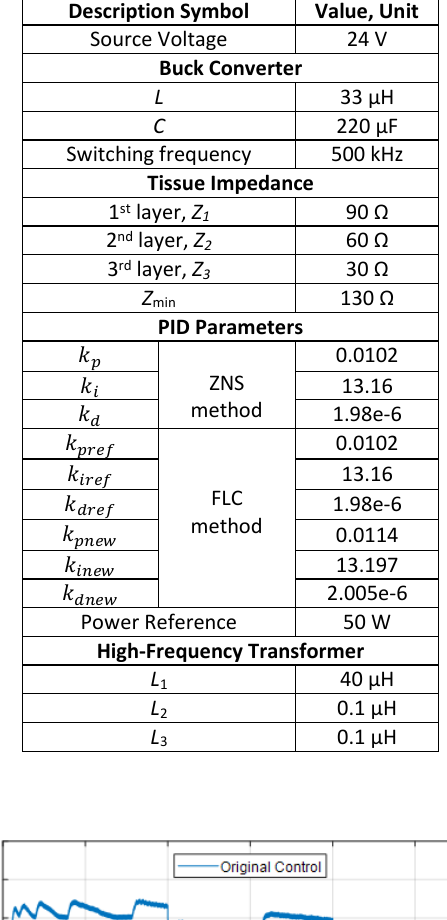
Table 1: Simulation specifications of the proposed ESU.